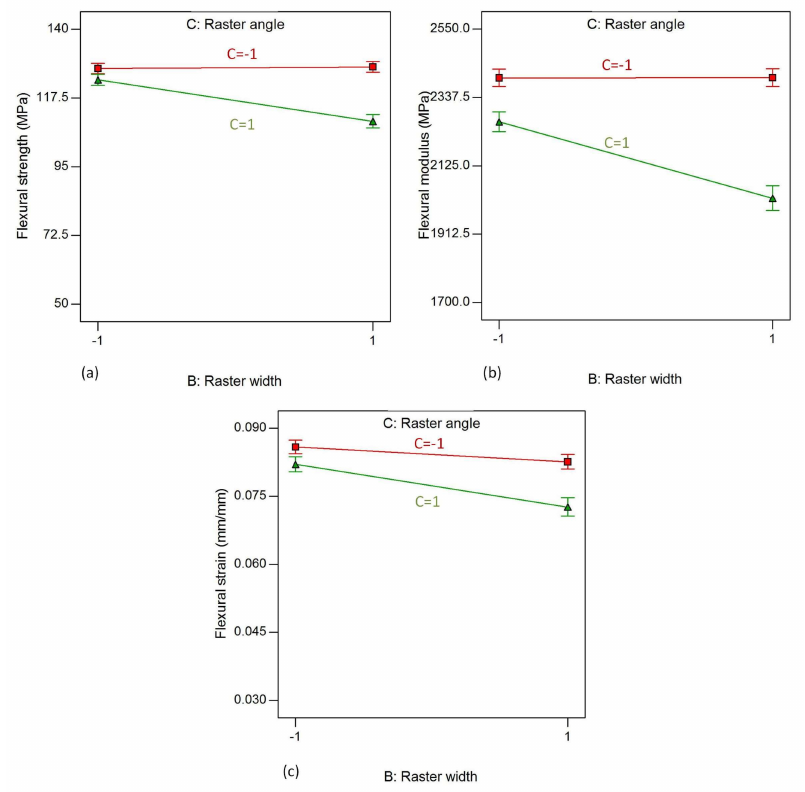
Figure 16. Interaction effect of raster width and raster angle on ( a ) flexural strength; ( b ) flexural modulus and ( c ) flexural strain, while air gap, contour number and contour width are kept constant at their highest